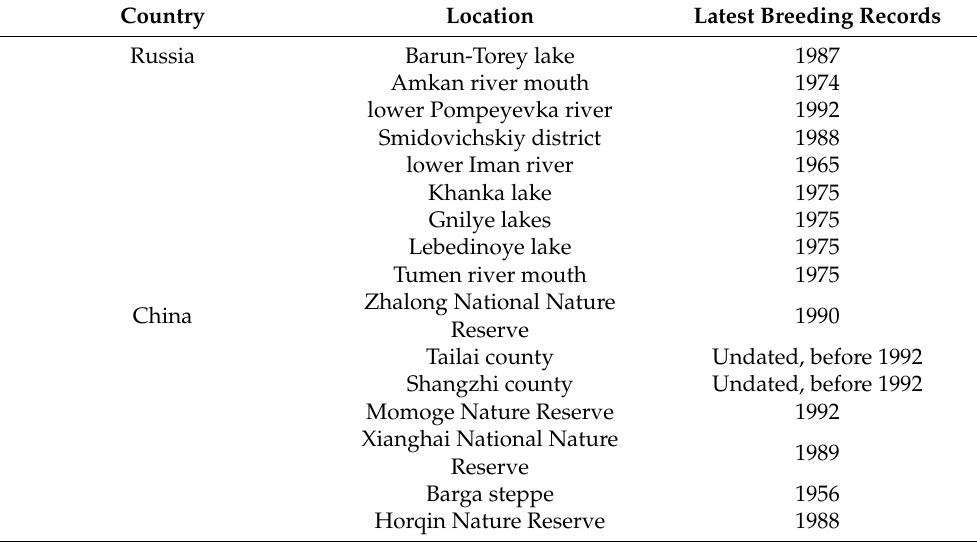
Table 3. Historical breeding sites of Baer’s